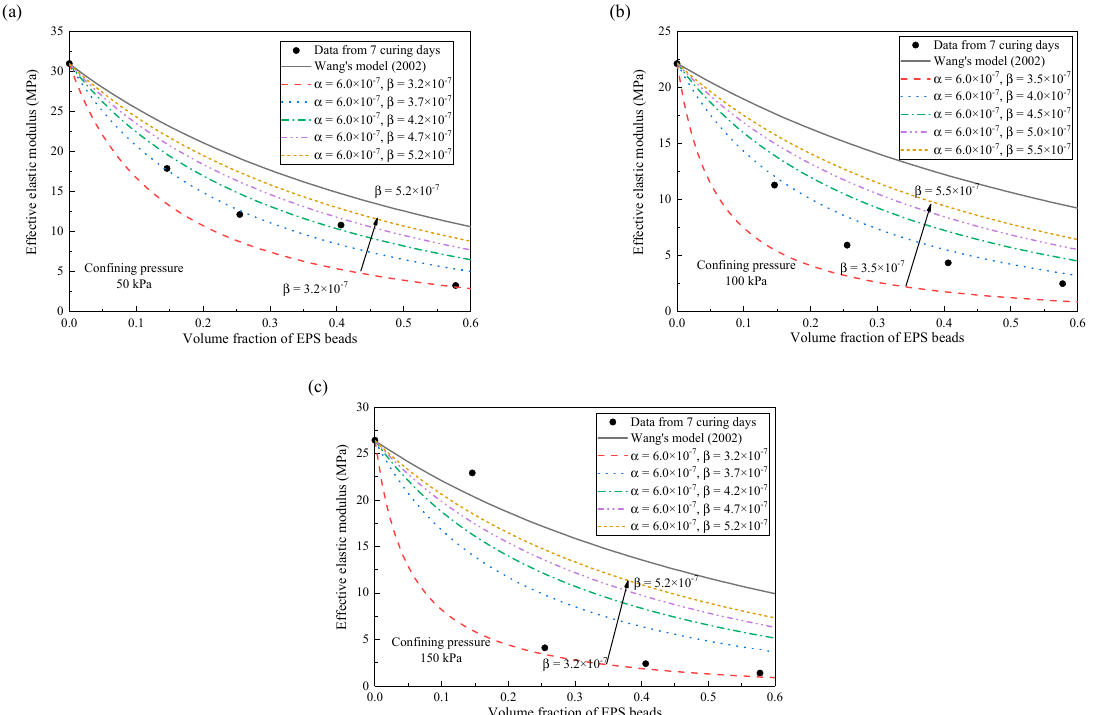
Figure 6. E ff ects of imperfect interface parameter β on e ff ective elastic modulus under di ff erent Figure 6. Effects of imperfect interface parameter β on effective elastic modulus under different confining pressures. ( a ) 50 kPa. ( b ) 100 kPa. ( c ) 150 confining pressures. ( a ) 50 kPa. ( b ) 100 kPa. ( c ) 150 kPa.